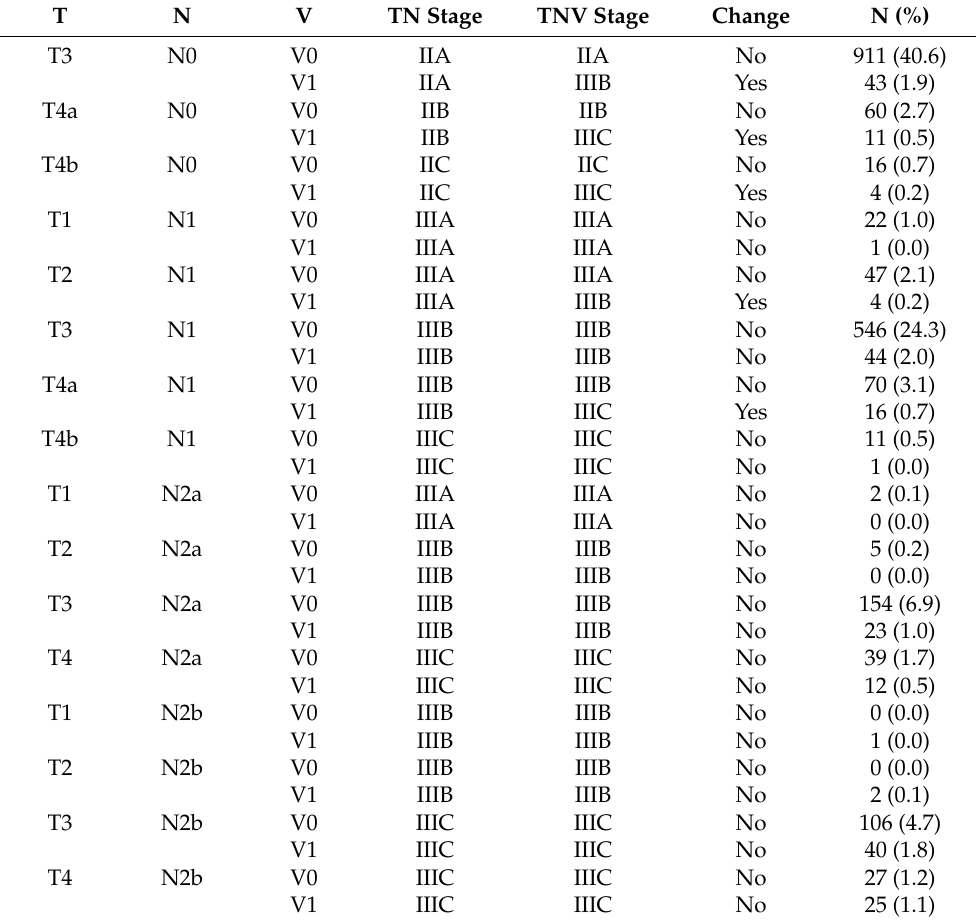
Table 5. The details of TN stage and TNV stage in stage II-III colon